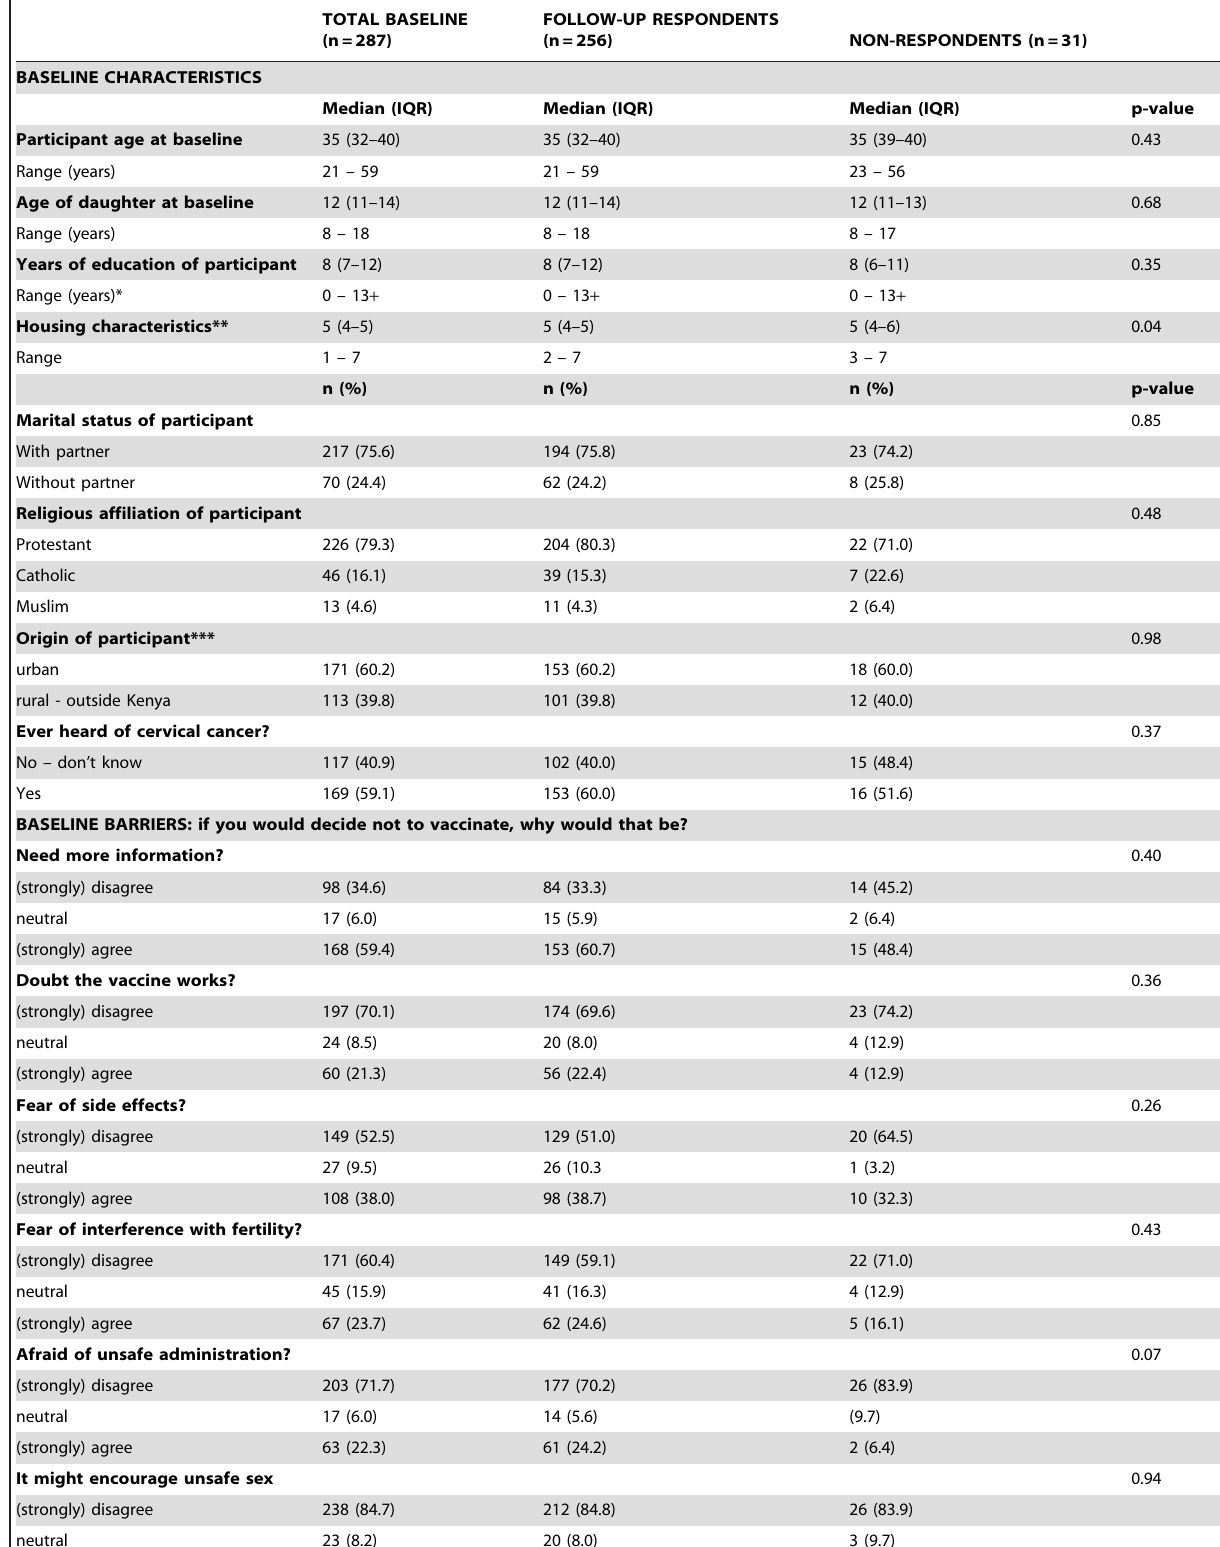
Table 1. Baseline characteristics, perceived barriers and acceptance of the HPV vaccine; comparing respondents and non- respondents of the follow-up